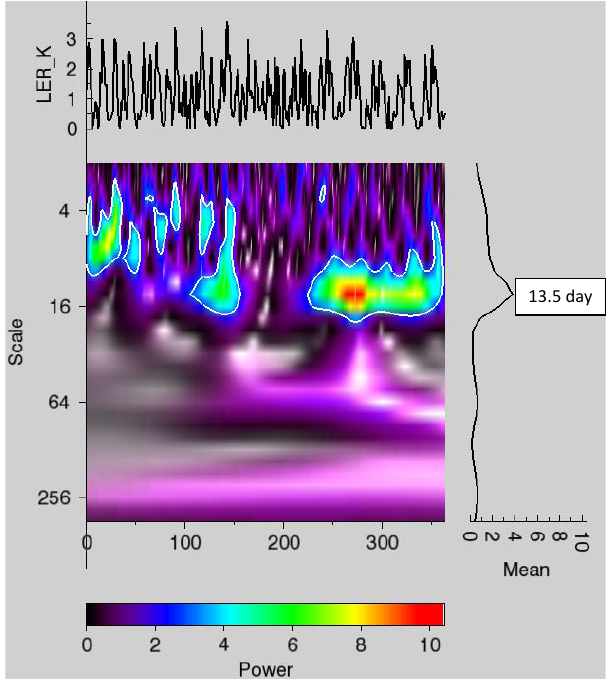
Figure 5. Morlet wavelet K index power spectrum for LER during 2007 showing the periodicities at a confidence level of 95% (in- dicated by the white contour lines). The absence of the 27.0-day geomagnetic-activity recurrence interval is to be noted.